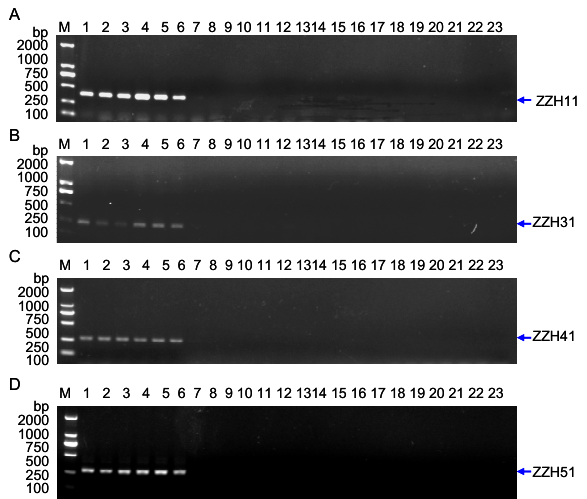
Figure 5. Development of stable RAPD-sequence-characterized amplified region (SCAR) markers for ZZH11, ZZH31, ZZH41 and ZZH51. ( A ) A SCAR marker ZZH11; ( B ) A SCAR marker ZZH31; ( C ) A SCAR marker ZZH41; ( D ) A SCAR marker ZZH51. Lanes 1~6 indicate the different samples of G. jasminoides Ellis var. grandiflora Nakai listed in Table 1. Lanes 7 and 8 are two samples of Lonicera japonica from Hunan and Hubei; Lane 9 is one sample of Penthorum chinense ; Lane 10 is one sample of Ganoderma lucidum ; Lanes 11 and 12 are two samples of Litchi chinesis from Guangdong and Sichuan; Lanes 13 and 14 are two samples of Dimocarpus Longan from Fujian and Sichuan; Lane 15 is one sample of Dimocarpus confinis from Guangxi; Lanes 16 and 17 are two samples of Ginkgo Biloba from Sichuan and Hunan; Lanes 18 and 19 are two samples of Angelica sinensis from Sichuan and Gansu; Lane 20 is one sample of Gastrodia elata ; Lanes 21 and 22 are two samples of Canarium album Guangdong and Sichuan; Lane 23 is negative control without DNA. The blue arrows indicate expected PCR products in size. Lane M indicates the DNA molecular weight marker DL2000.